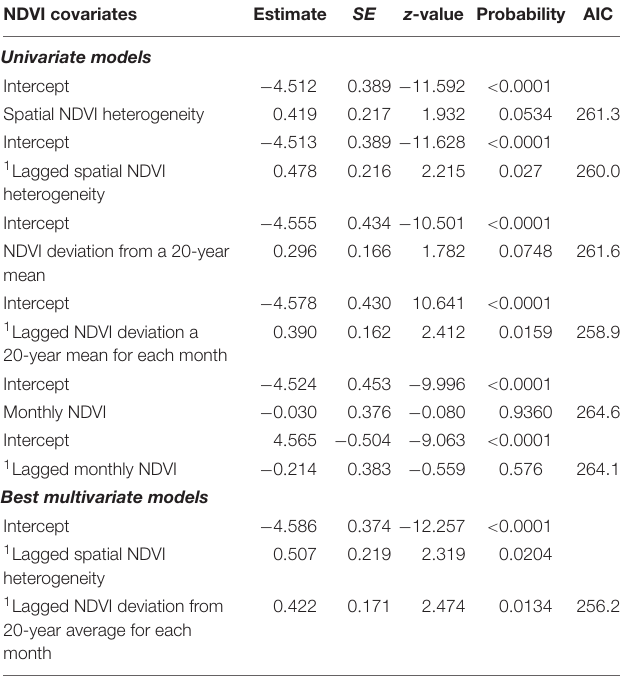
TABLE 9 | Univariate NDVI-metric Poisson models and their influence on the number of months in a year (intensity) anthrax was reported from wildlife areas in Kenya.